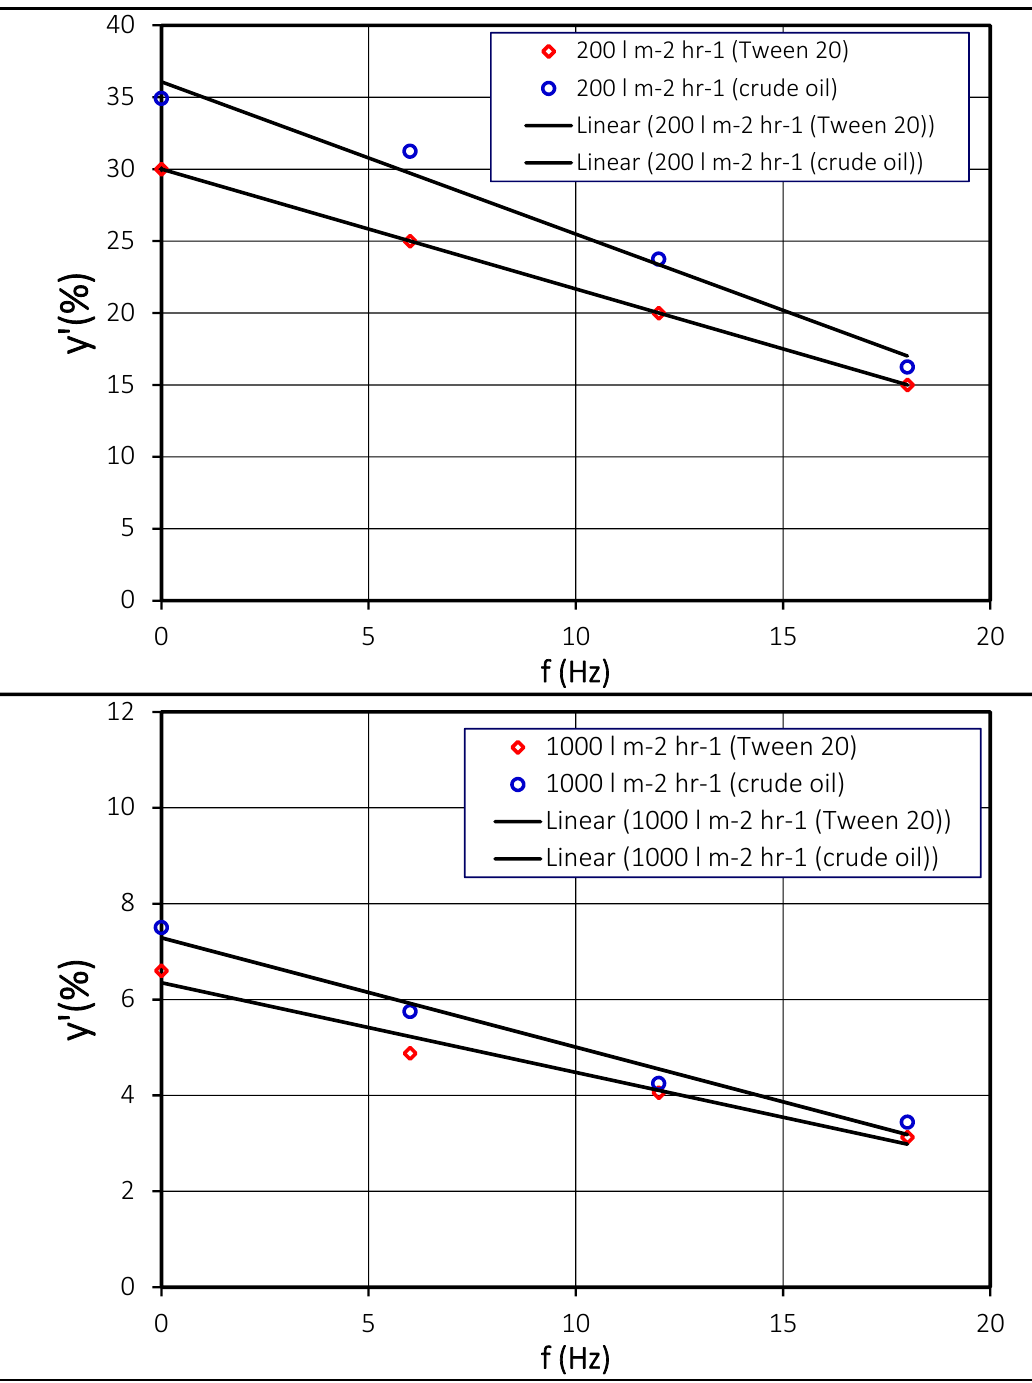
Figure 7. Impact of oscillation frequency, f(HZ), on the pore blockage area, y’, in percentage. Stable vegetable oil droplets (stabilized by Tween 20) and crude oil droplets at ( a ) 200 lm − 2 h − 1 ( b ) 1000 lm − 2 h − 1 . Table 1 shows the number of crude oil drops in the permeate and permeate concentration obtained at different shear rates. It is clear that both the number of drops in the permeate and the crude oil concentration in the permeate were influenced by the applied shear. The number of drops and crude oil concentration were reduced with the applied shear